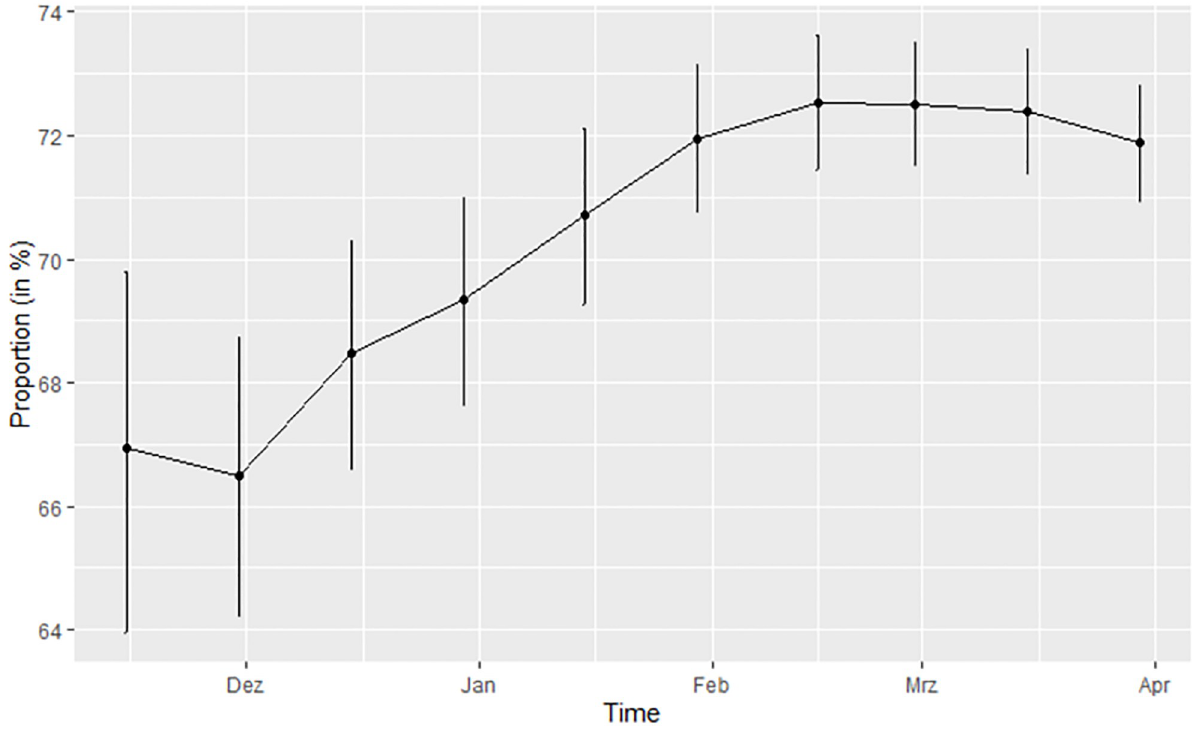
Fig 2. (Cumulative) relative frequency of medical appointment over time, with Clopper-Pearson confidence intervals for binomial proportions.